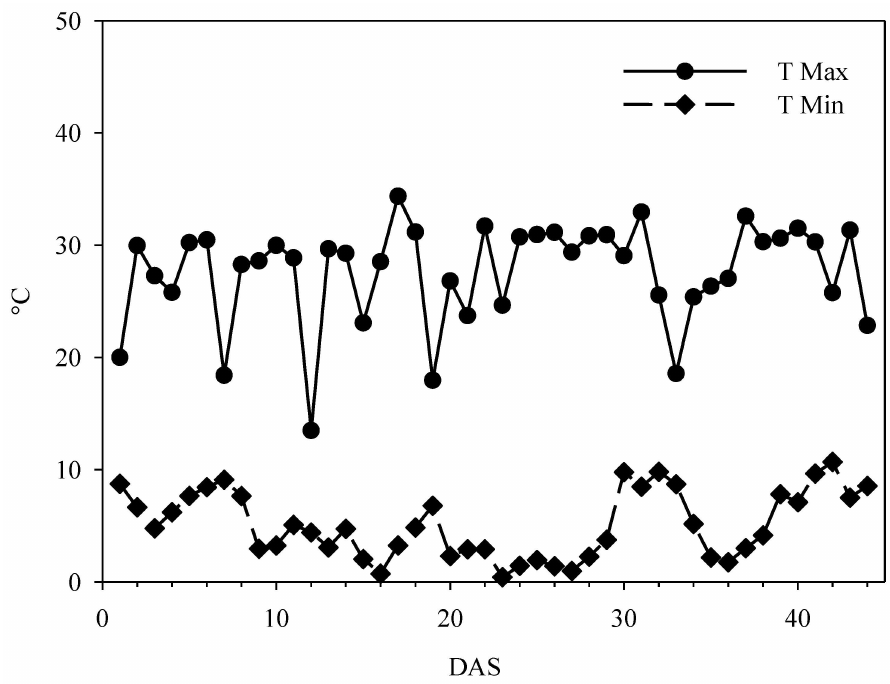
Figure 1. Daily maximum and minimum air temperature during the growing period of spinach. DAS: day after